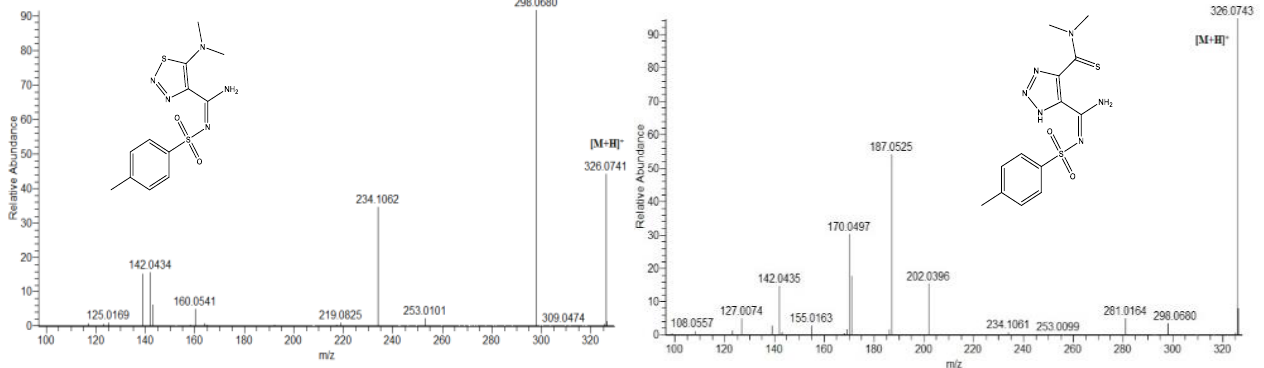
Figure 2. (+)ESI-MS/MS mass spectra of isomeric 1,2,3-thiadiazole 1aS and 1,2,3-triazole 1aN .